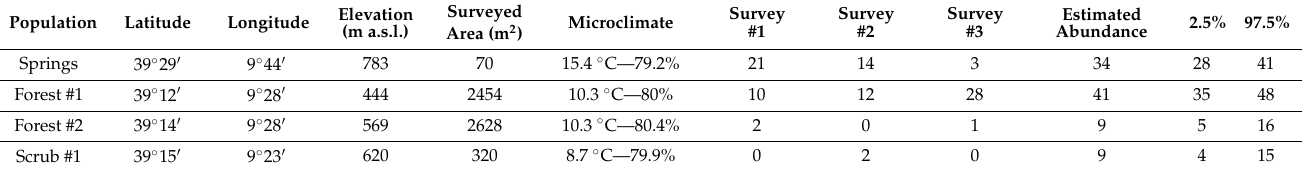
Table 2. Data related to the monitored populations of Speleomantes sarrabusensis . Along with general information on the location of the site, the surveyed areas, and the local microclimate, for each population we provide the number of observed individuals during each survey and the estimation of the population abundance. The elevation represents the average elevation of the monitored area. The abundance (mode) is accompanied by the confidence interval